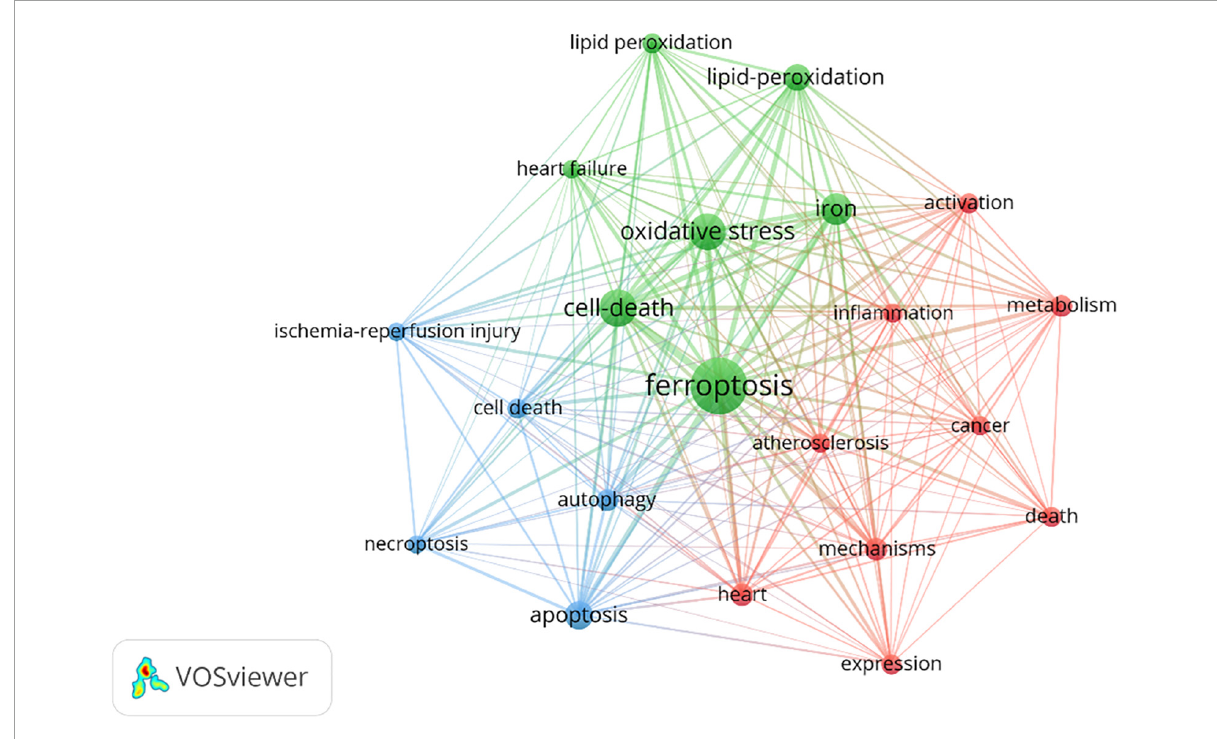
FIGURE7 Visualization map of top 20 keywords.